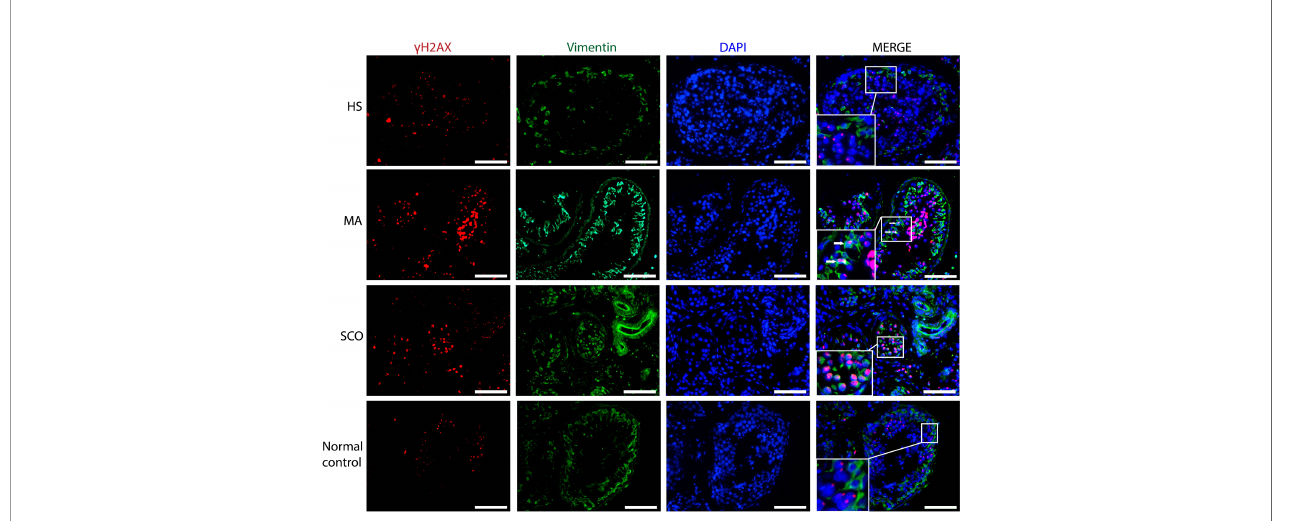
FIGURE 4 | Immuno fl uorescence staining of g H2AX (red), somatic cell marker Vimentin (green), nuclear marker DAPI (blue) in un-dilated seminiferous tubules in samples from HS, MA, and SCO samples. White arrow indicated g H2AX-positive Sertoli cells in MA. As almost all Sertoli cells expressed g H2AX in SCO, we did not add arrow to indicate them. There were no g H2AX-positive Sertoli cells in HS and normal control group. Scale bar: 100 m